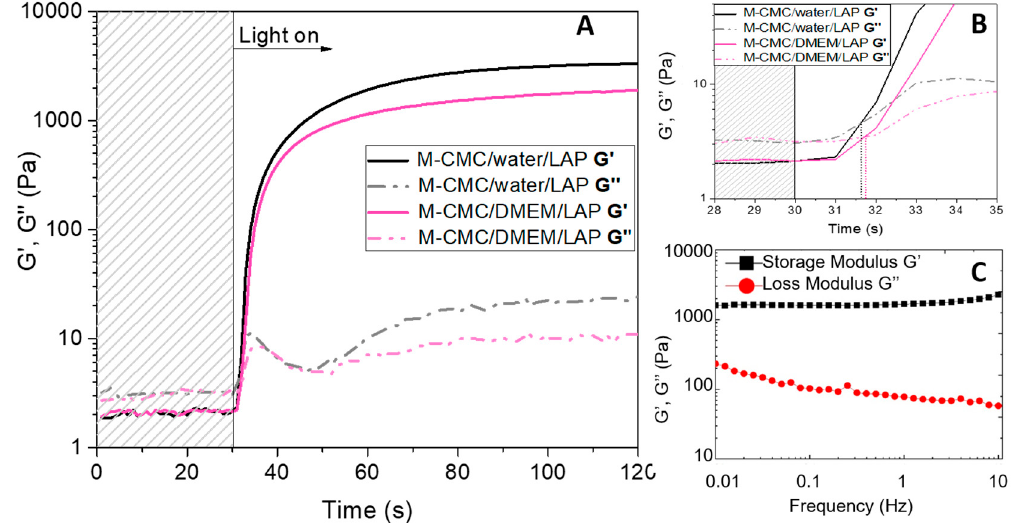
Figure 2. ( A ) Photorheology of methacrylated carboxymethyl cellulose (M-CMC) 20 mg/mL (2 wt% lithium phenyl-2,4,6-trimethylbenzoylphosphinate (LAP)) solubilized in water (black) or in culture medium (pink). ( B ) Gel point. Film thickness 300 m. ( C ) Frequency sweep. Strain rate 1% and oscillation frequency from 0.01 to 10 Hz.